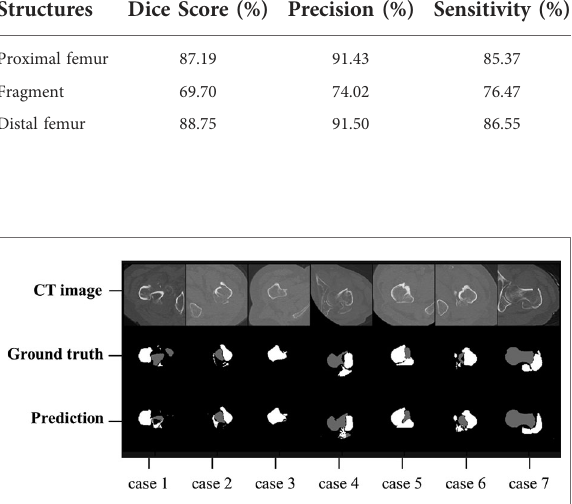
FIGURE 8 Automatic and manual labeled masks in cross-dataset.